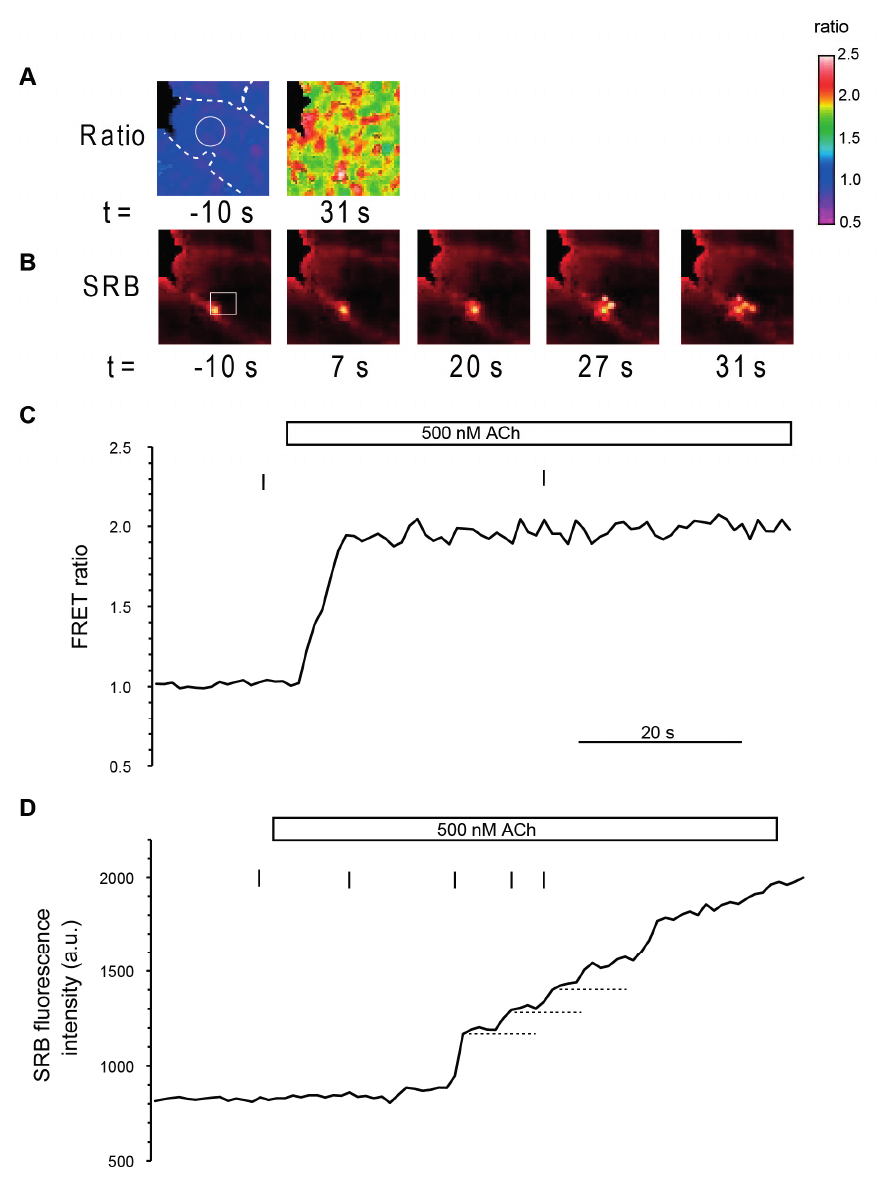
Figure 4. Ca 2+ -dependent sequential compound exocytosis simultaneously visualized by FRET and polar tracer signals. ( A ) FRET ratio images before ( t = − 10 s) and after ( t = 31 s) stimulation at the time indicated by the vertical bar in ( C ); ( B ) Fluorescence images of SRB before ( t = − 10 s) and after ( t = 7, 20, 27, and 31 s) stimulation at the time indicated by the vertical bar in ( D ); and ( C , D ) Time course of FRET ratio ( C ) and SRB fluorescence changes ( D ) when a high concentrations of agonist (500 nM ACh) was applied. Intensities in the white circle in ( B ) and the white box in ( C ) are plotted. The intensity of the FRET signal promptly reached the value of R max estimated in Figure 2, indicating saturation. SRB fluorescence exhibited stepwise increases (horizontal dotted lines) simultaneous with sequential exocytotic events, shown in ( B ) (timings at − 10, 7, 20, 27, and 31 s); and ( E ) The number of exocytotic events observed in each acinar cell in a 10-min interval in response to stimulation with various concentrations of ACh. The number of cells measured ( n ) at each concentration was as follows: 6 (5 nM), 9 (10 nM), 6 (50 nM), 9 (100 nM), and 13 (500